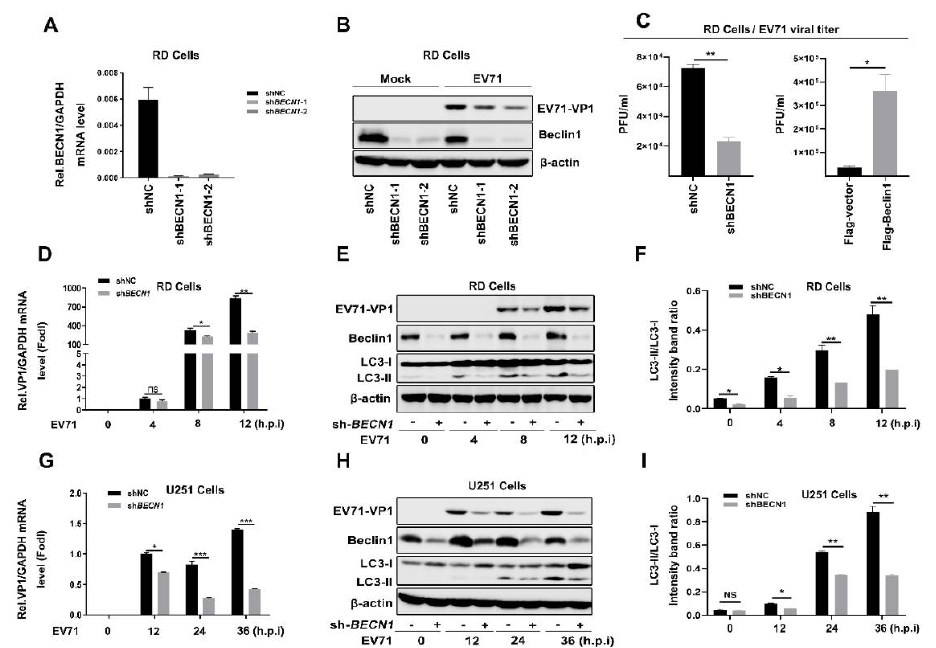
Figure 3. Knockdown of BECN1 attenuates EV71 replication in RD and U251 cells. ( A , B ) RD cells were transfected with pLKO.1-shNC, pLKO.1-shBeclin1-1, pLKO.1-shBeclin1-2, and the e ffi ciency of knockdown was testified by Real-time PCR ( A ). The transfected RD cells were infected with EV71 (MOI = 1), and the protein levels of EV71-VP1 and Beclin1 were detected by Western blot with β -actin as an internal control ( B ). ( C ) RD cells were transfected with Flag-vector or Flag-Beclin1, pLKO.1-shNC or pLKO.1-shBeclin1 and infected with EV71 for 12h, and supernatants were collected for TCID50 assay. ( D – F ) The stable RD cells were infected with EV71 (MOI = 1) for di ff erent periods. The RNA and protein levels of EV71-VP1 were detected by Real-time PCR with GAPDH ( D ) and Western blot with β -actin as controls ( E ), and the LC3-II / LC3-I ratio was measured( F ), respectively. ( G – I ) The stable U251 cells were infected with EV71 (MOI = 2) for di ff erent periods. The RNA and protein levels of EV71 VP1 were detected by Real-time PCR ( G ) and Western blot ( H ), and the LC3-II / LC3-I ratio was measured ( I ), respectively. Graph expressed as mean ± SD, ns, not-significant; * p < 0.05; ** p < 0.01; *** p < 0.001.